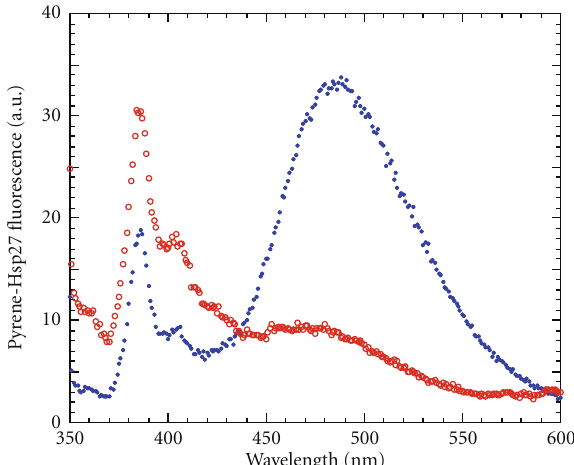
Figure 5: Fluorescence spectrum of pyrene-Hsp27 upon interac- tion with F-actin. Pyrene-Hsp27 (1 μ M) in the absence (blue closed circles) and presence (red open circles) of 5-fold molar excess of F- actin at 37 ◦ C in F-bu ff